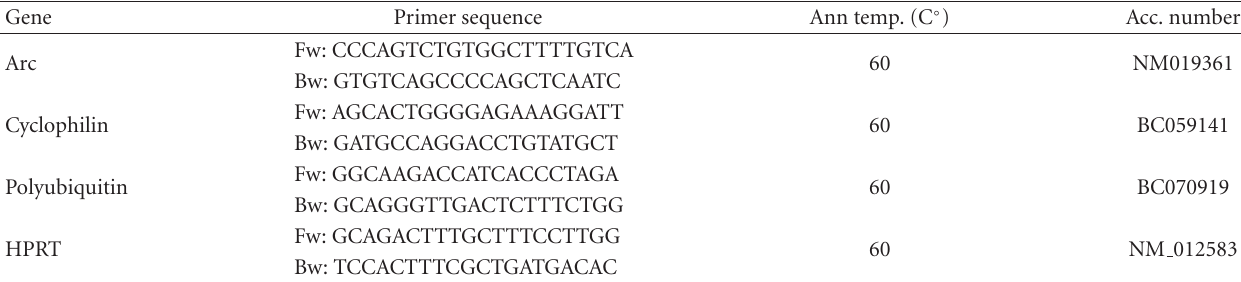
Table 1: Overview over primer sequences and accession numbers for the analyzed